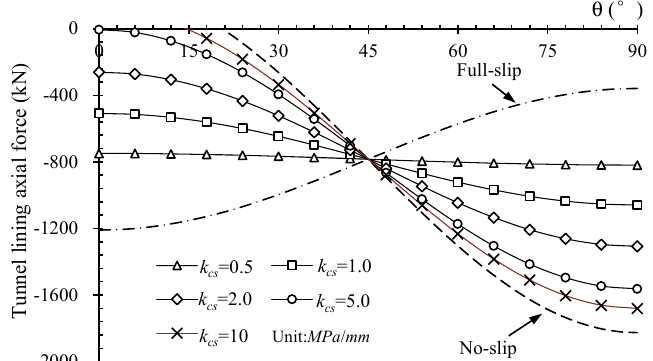
Figure 16. Influence of k cs on tunnel lining axial force.